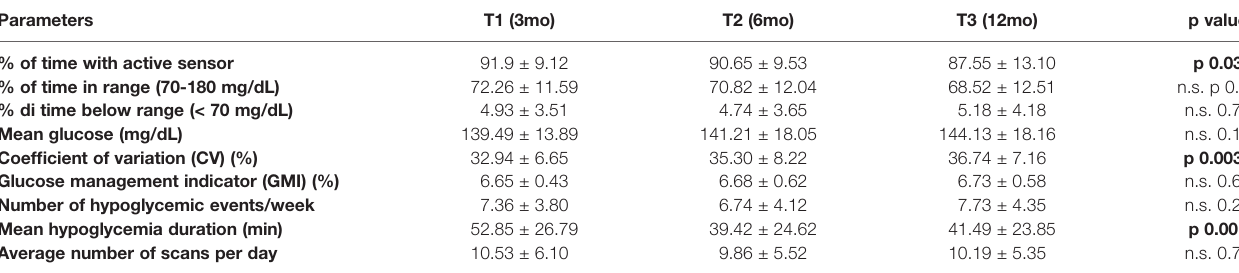
TABLE 3 | four week time glucose metrics in Group A (n = 85).